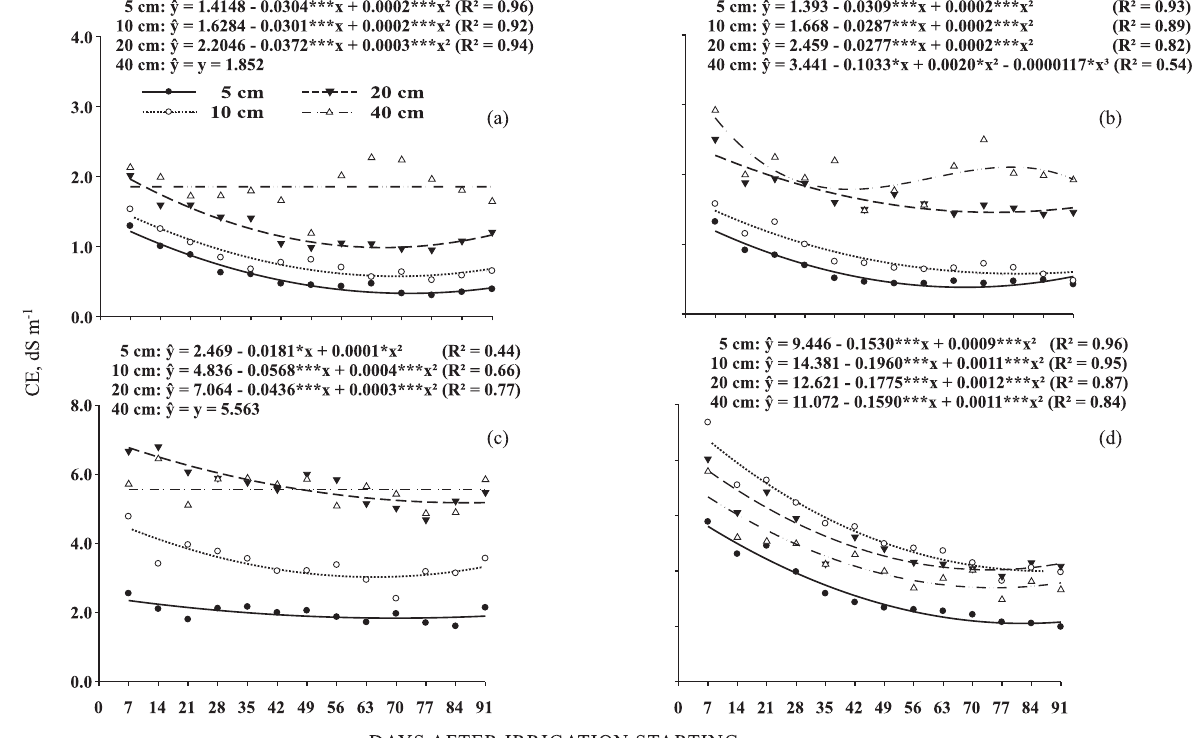
respectively.Figure 7. Electrical conductivity in the soil solution at different depths and salinity levels: Casamento (a) Cavalhada (b) Banhado (c) Sinval (d). *, **, ***: significant at 10, 5 and 1%, by the F-test,